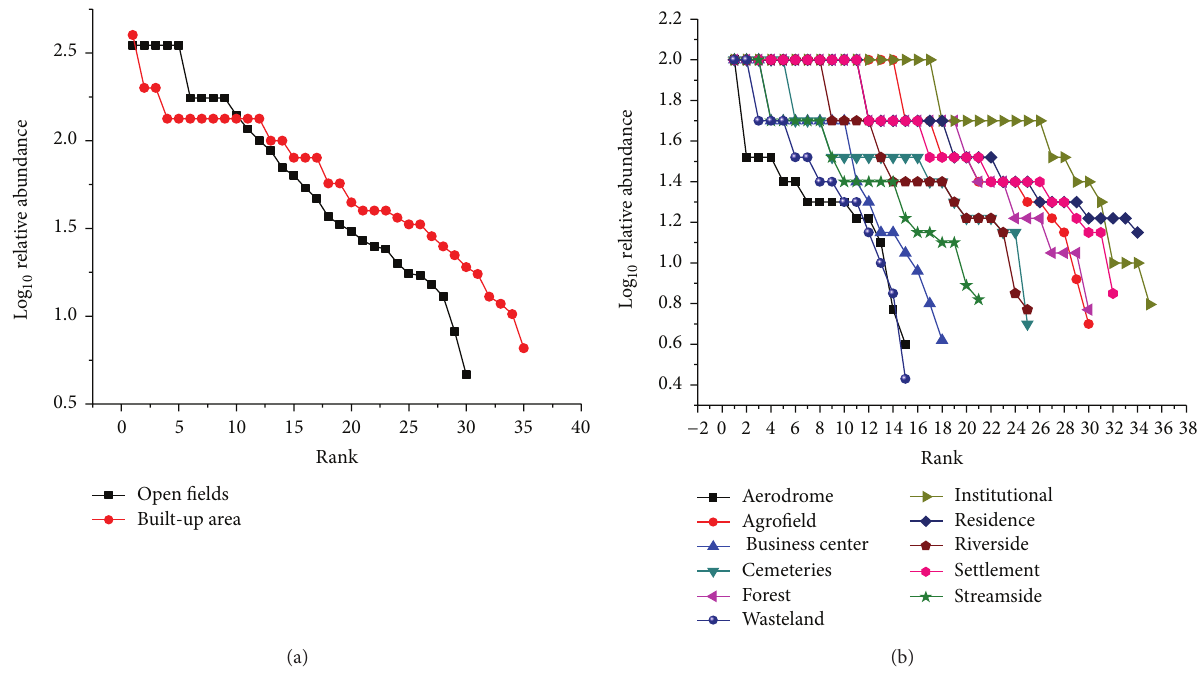
Figure 9: Species rank/abundance: (a) in macrolandscape types and (b) in microlandscape types.